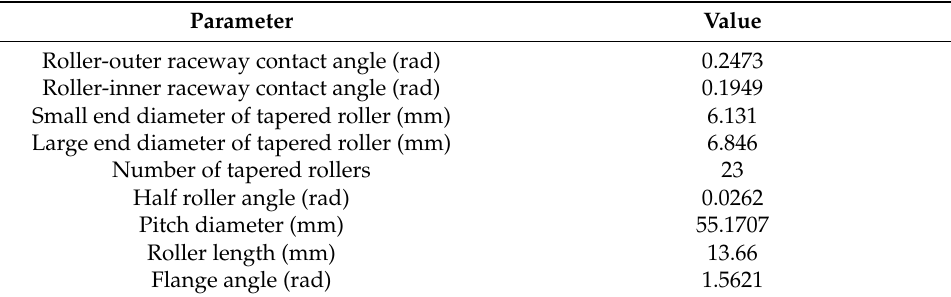
Table 1. Structure and material parameters of 32008 TRB. Parameter Value Roller-outer raceway contact angle (rad) 0.2473 Roller-inner raceway contact angle (rad)